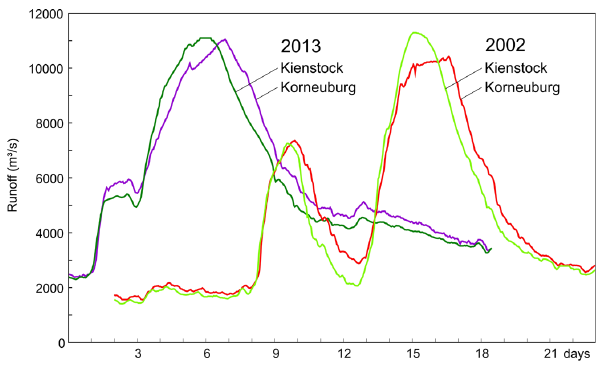
Fig. 12. Comparison of the 2013 flood (dark colours) and the 2002 flood (light colours) for the Kienstock and Korneuburg stream gauges at the Danube which are 73km